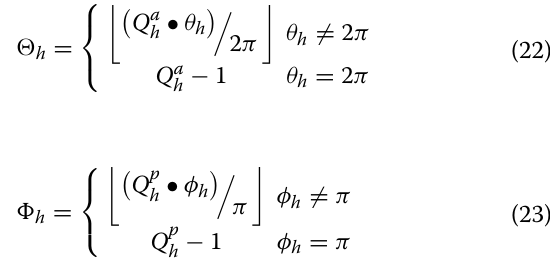
a Q p where Q h denote their gray levels or quantifica- h and tion numbers, respectively, and ⌊ X ⌋ was defined before as the infimum of X .